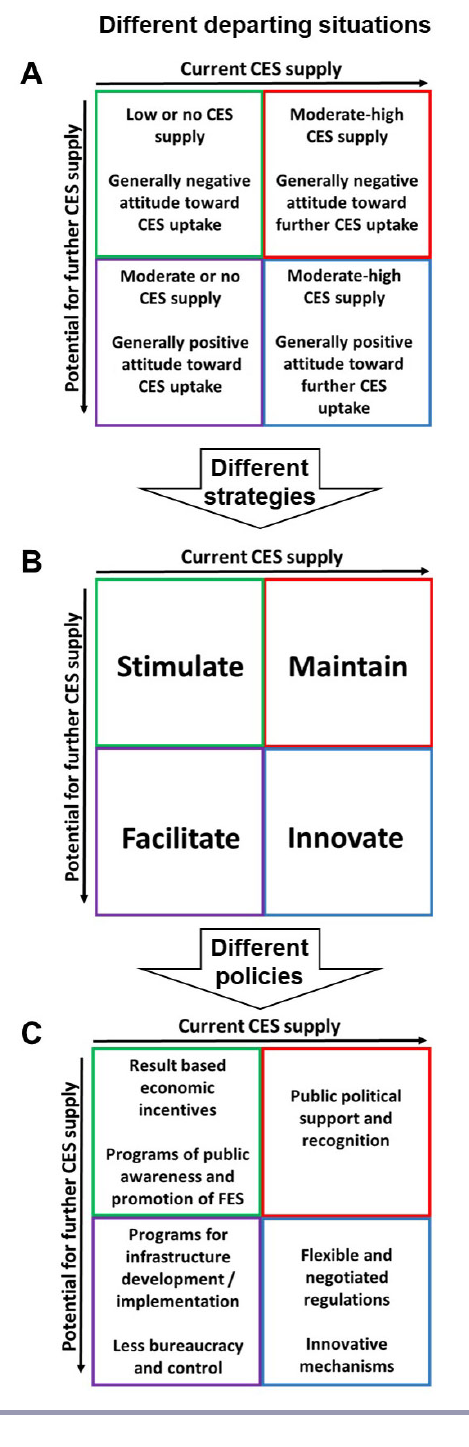
Fig. 4 . Different departing situations (A) would require different policy strategies (B) and policy mechanisms to promote cultural ecosystem services (CES) supply in European forests